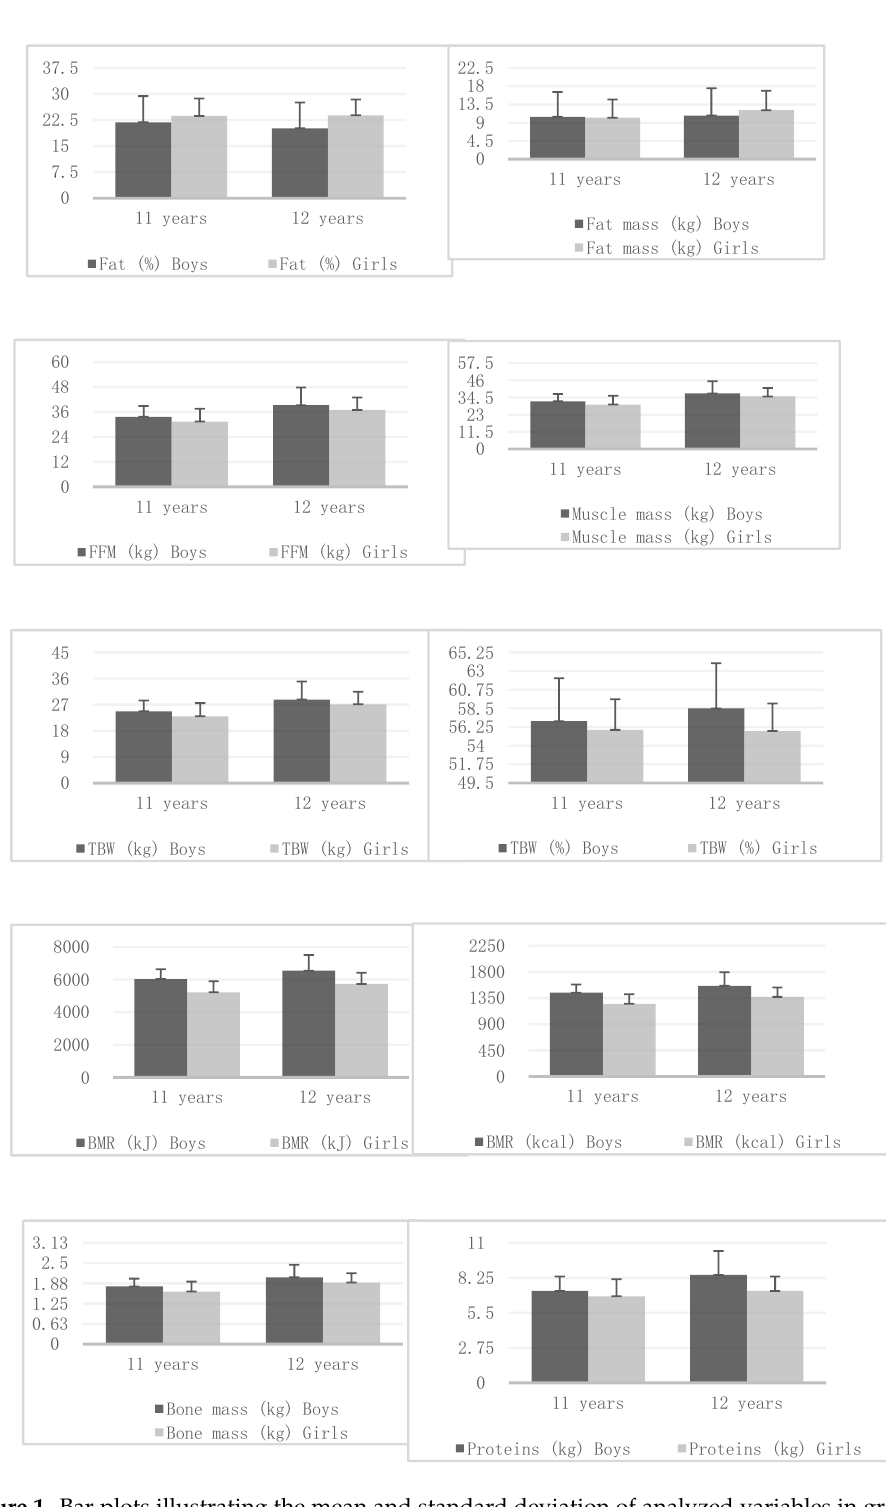
Figure 1. Bar plots illustrating the mean and standard deviation of analyzed variables in groups of boys and girls. Fat (%) showed highly significant ( p = 0.005) differences concerning the type of spine in post-hoc analyses, and a significant difference was noted when comparing the groups “increased kyphosis and increased lordosis” with “decreased kyphosis and decreased lordosis” ( p = 0.003) and “decreased